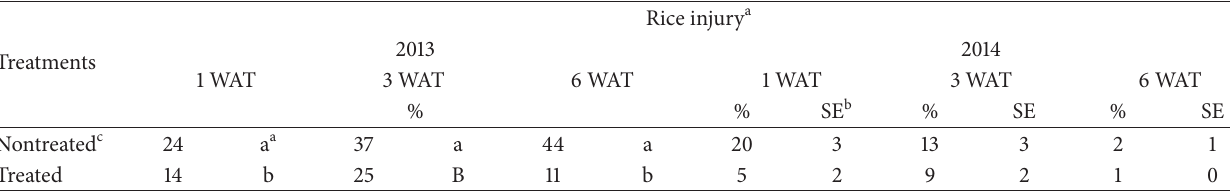
Table 1: Impact of insecticide seed treatment on rice injury 1, 3, and 6 weeks after treatment averaged over reduced rates of imazethapyr (Newpath) and glyphosate (Roundup PowerMax) in 2013 and 2014. Rice injury a 2013 2014 Treatments 1 WAT Nontreated c 24 a a Treated 14 b 25 B 11 b 5 2 9 2 1 Timings that did not meet the assumptions of ANOVA are reported as means followed by the standard error of the mean (SE). c “Nontreated” meansthericeseedreceivedfungicideonlyandnoinsecticideseedtreatment whereas“treated”meansthericeseedwastreatedwith198g/45kg of CruiserMaxx Rice. Table 2: Main effect of herbicide treatment on rice injury 1, 3, and 6 weeks after treatment (WAT) in 2013 and 2014. Rice injury a Rate 2013 2014 Treatments 1 WAT 3 WAT 6 WAT 1 WAT 3 WAT g ai/ha e % SE Glyphosate c 39.42 9 c a c Glyphosate 78.76 11 c 11 Glyphosate 157.54 33 a Imazethapyr d Imazethapyr 8.74